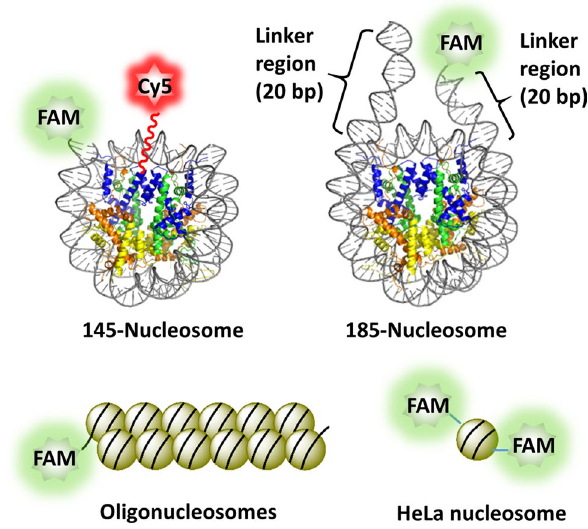
Figure 1. Structures of nucleosomes employed in the present study. For 145- and 185-nucleosome and oligonucleosomes, one FAM moiety was tagged on the 5 ′ end of one DNA strand. For the HeLa nucleosome, FAM was introduced to Lys residues of histones by chemical modification, and therefore, one HeLa nucleosome may contain multiple FAM moieties. For the dual labelled 145-nucleosome, one Cy5 fluorophore was tagged on Cys35 of each histone H3. Figures of 145-nucleosome and 185-nucleosome created using data from PDB: 3LZ0 and 1ZBB,